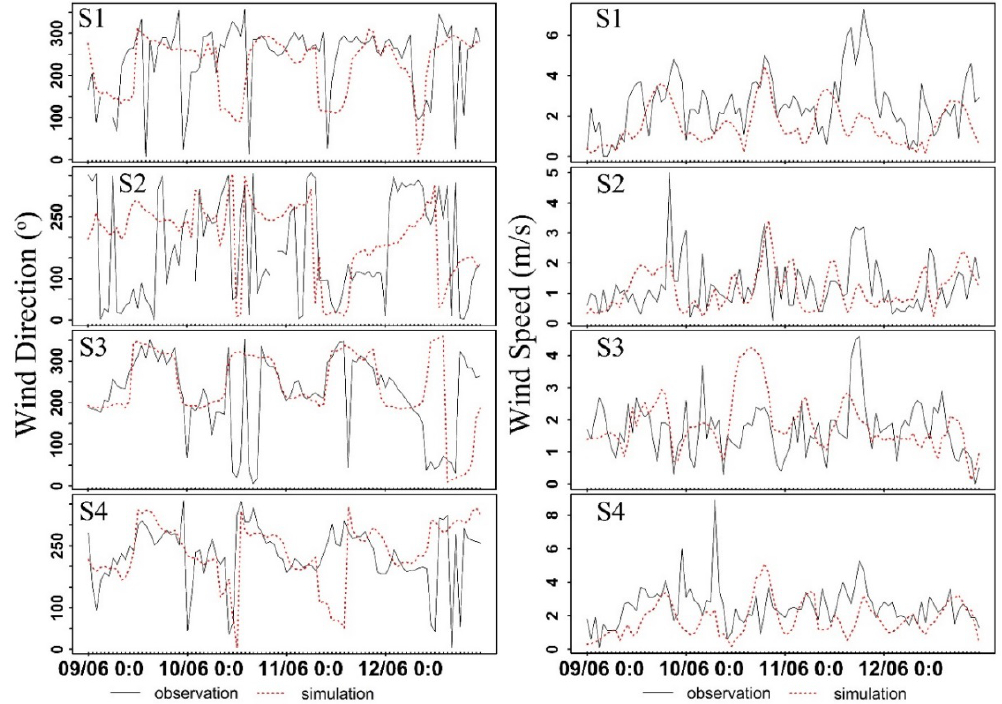
Figure 5. The hourly wind direction and wind speed validation at the 4 boundary stations during 9–12 June 2016.